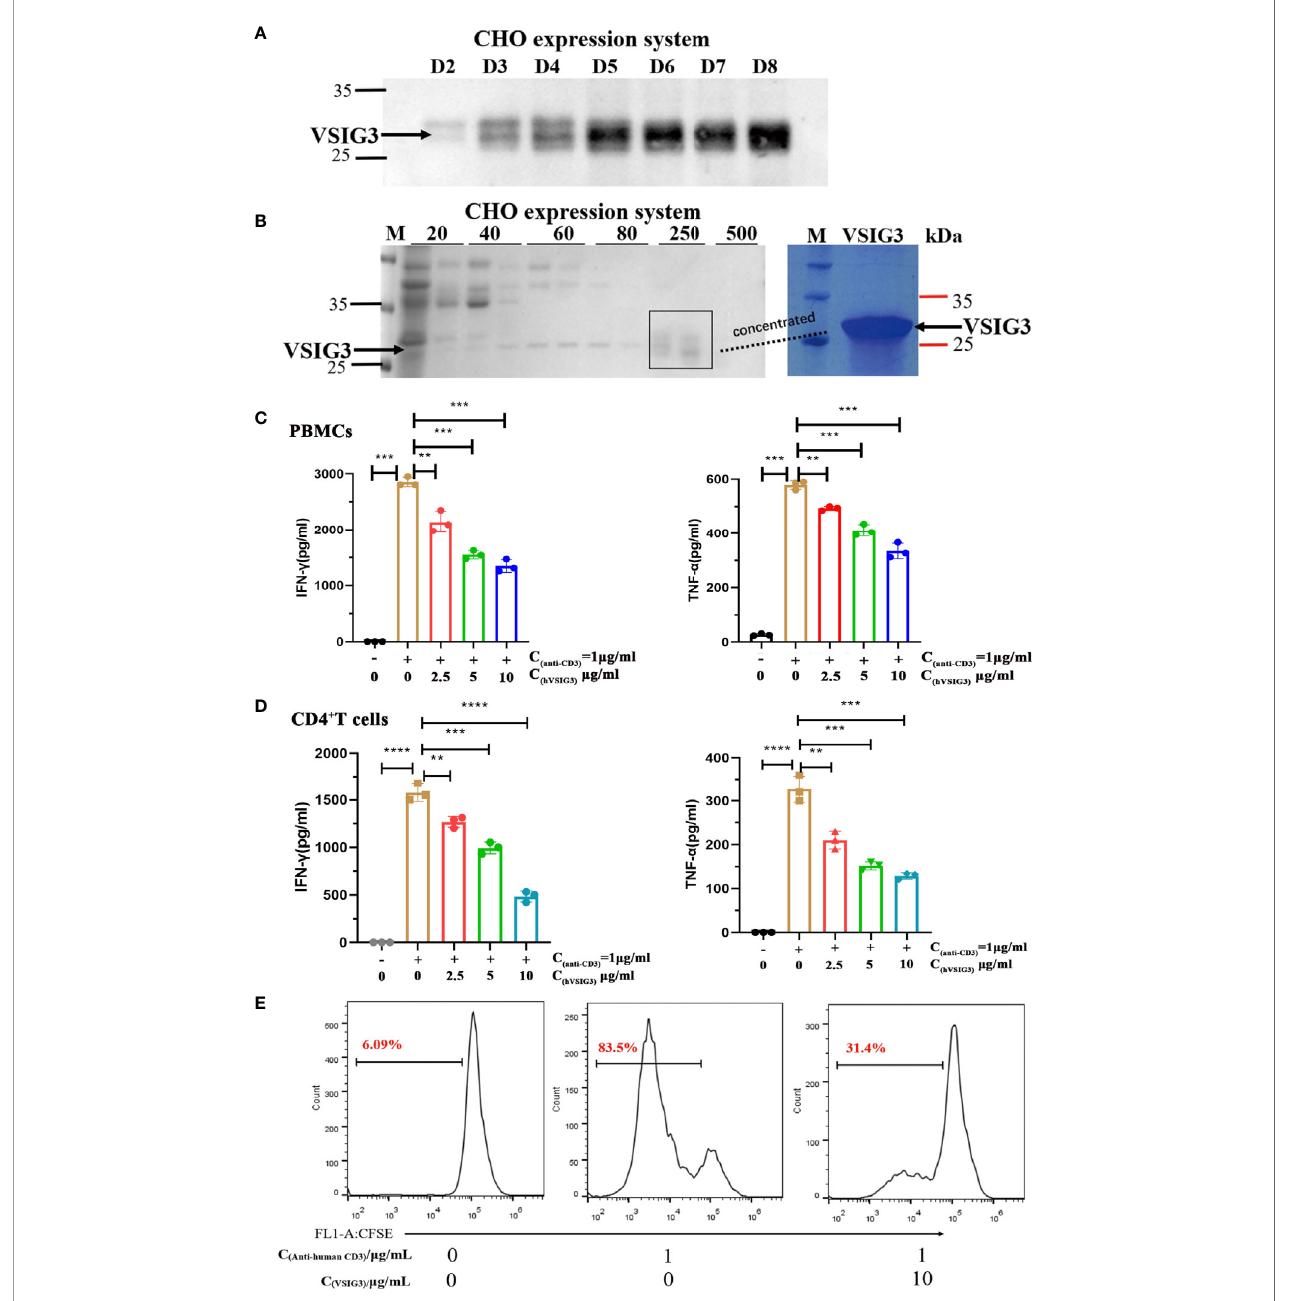
FIGURE 2 | VSIG3 protein inhibits T cell function. (A) VSIG3 expression by CHO cells was detected by western blot after 2-8 days of culturing. (B) The VSIG3 protein was eluted with different concentrations of imidazole solutions (20 mM, 40 mM, 60 mM, 80 mM, 250 mM, 500 mM) (Left); Coomassie blue stained PAGE of concentrated VSIG3 protein (Right). (C) VSIG3 inhibits the cytokine secretion of activated PBMCs. Anti-human CD3 antibody (1 m g/mL) and different concentrations of VSIG3-ECD protein were coated on 96-well plates. PBMCs (1×10 5 cells/well) were added for 48 hours to detect the secretion of IFN- g and TNF- a in the supernatant. **p<0.01 and ***p<0.001 vs. control. (D) VSIG3 inhibits the secretion of IFN- g and TNF- a in activated human CD4 + T cells. Anti-human CD3 antibody (1 m g/mL) and different concentrations of VSIG3-ECD protein were coated on 96-well plates. Human CD4 + T cells (1×10 5 cells/well) were added for 48 hours to detect the secretion of IFN- g and TNF- a in the supernatant. **p<0.01, ***p<0.001 and ****p<0.0001 vs. control. (E) VSIG3 inhibits the proliferation of activated PBMCs. CFSE-labeled PBMCs (1×10 5 cells/well) were stimulated by plate-bound anti-human-CD3 (1 m g/mL), and VSIG3 protein (10 m g/mL) was added. The proliferation levels of PBMCs were measured by fl ow cytometry on day 5. Representative results from three independent experiments are